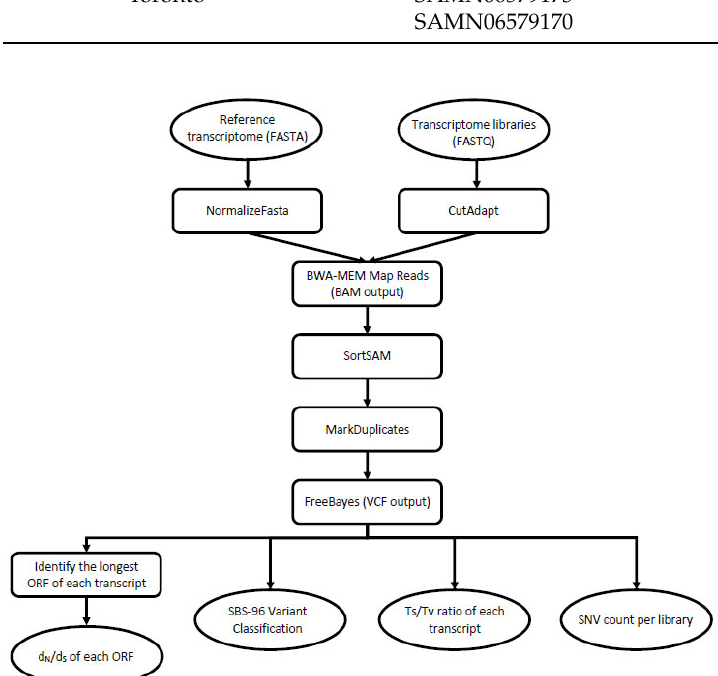
Figure 2. A graphical workflow depicting the major steps that we undertook in data processing. Oval shapes represent input/output, and the rectangular shapes represent the tools/processing steps. To begin, we accessed the nine NCBI-SRA library files (FASTQ format) and the corresponding reference assembly (FASTA format). From there, we used these data files in combination to generate the four principal analyses shown at the bottom of the flow chart.